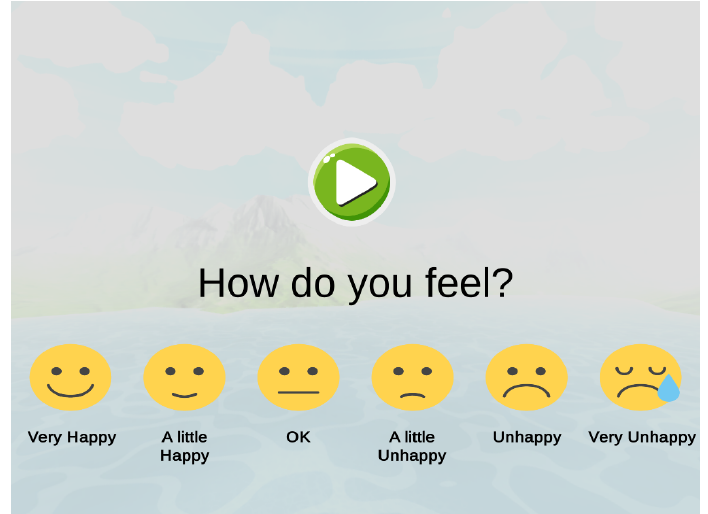
Figure 3. Audio Interactive